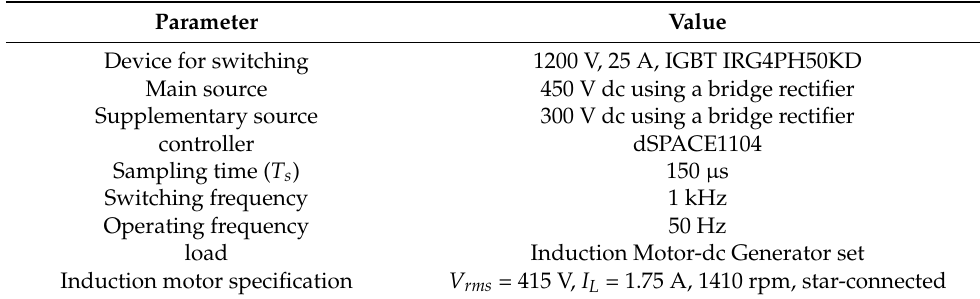
Table 2. Experimental prototype